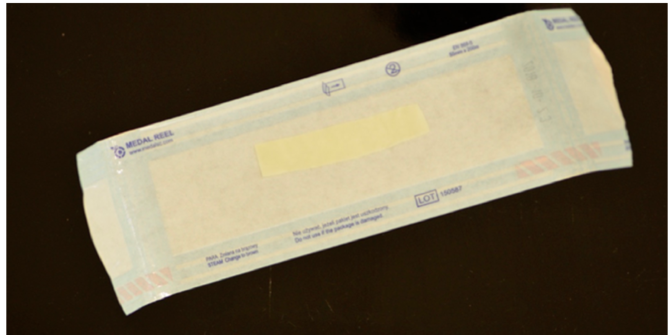
Figure 1. Sterile Latex flat drain.